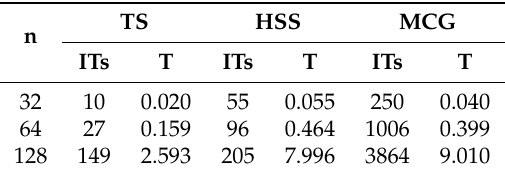
Table 2. Comparison of ITs and T when choosing r =